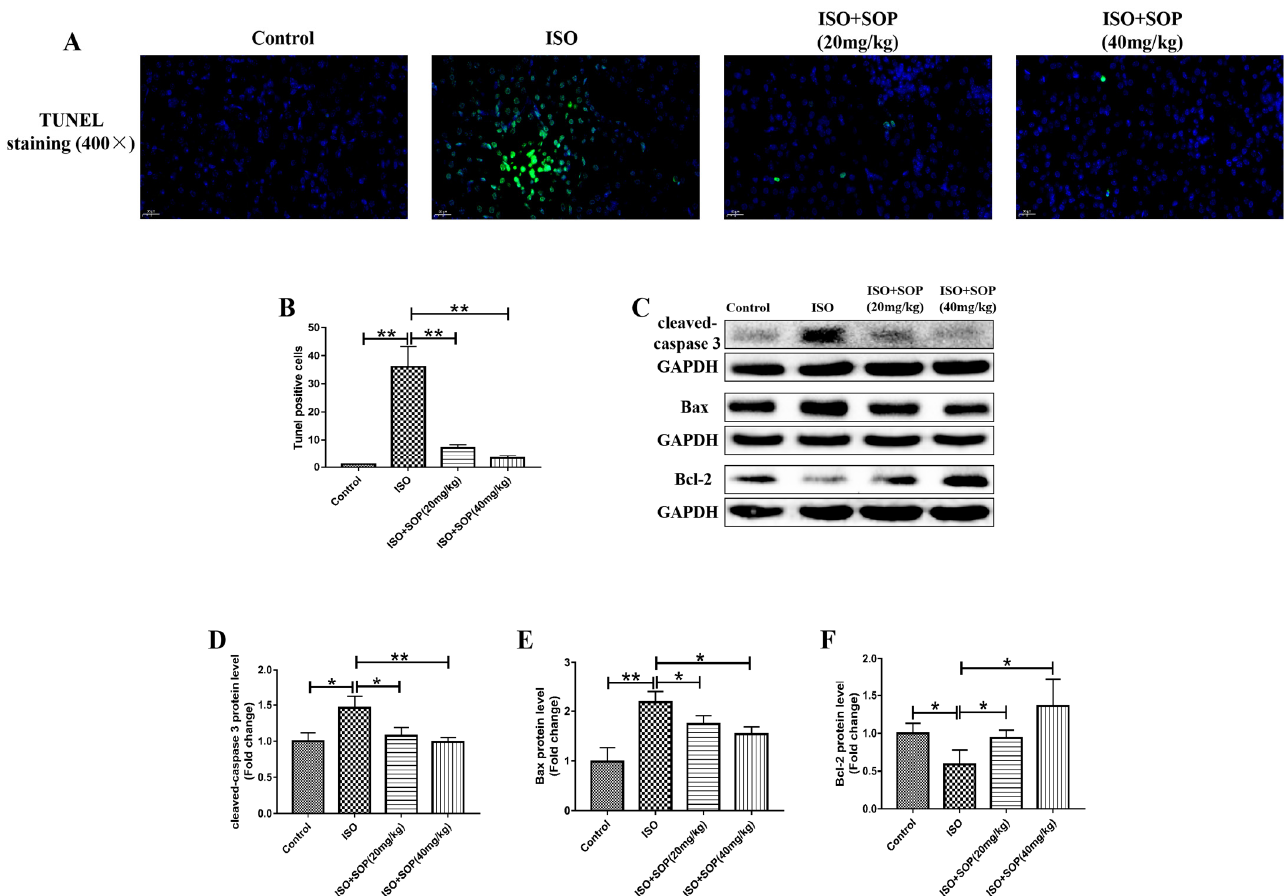
Figure 3. ( A , B ) A TUNEL staining assay was conducted to evaluate pathological changes in kidney tissues (n = 7–8). ( C – E ) The protein expression levels of apoptosis-related proteins such as cleaved- caspase 3 and Bax were explored using a Western blotting assay (n = 7–8). ( C , F ) The protein